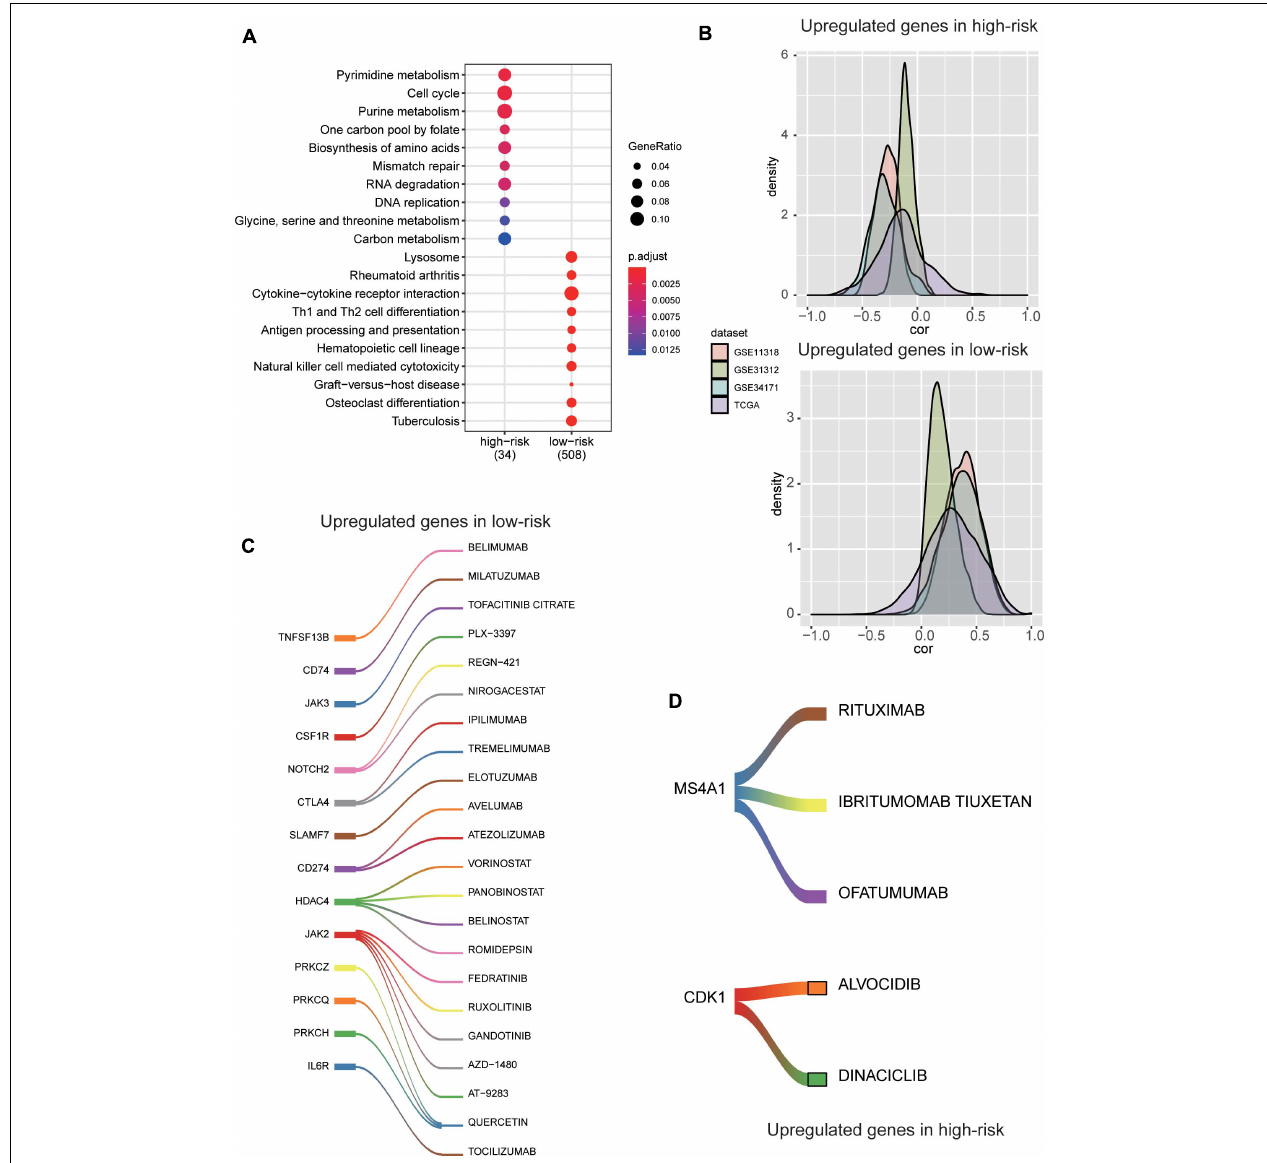
FIGURE 6 | The molecular characteristics and potential drugs for the two risk groups. (A) The top-ten GO terms enriched by the upregulated genes in high-risk and low-risk groups. The dots size and color represent the ratio of gene counts and statistical significance, respectively. (B) The probability density function of the Spearman’s correlation between the five prognostic genes and the differentially expressed genes (DEGs). The colors represent the validation datasets. (C) The upregulated immune checkpoint proteins and the corresponding drugs in the low-risk group. (D) The upregulated cell cycle kinase and their potential drugs in high-risk